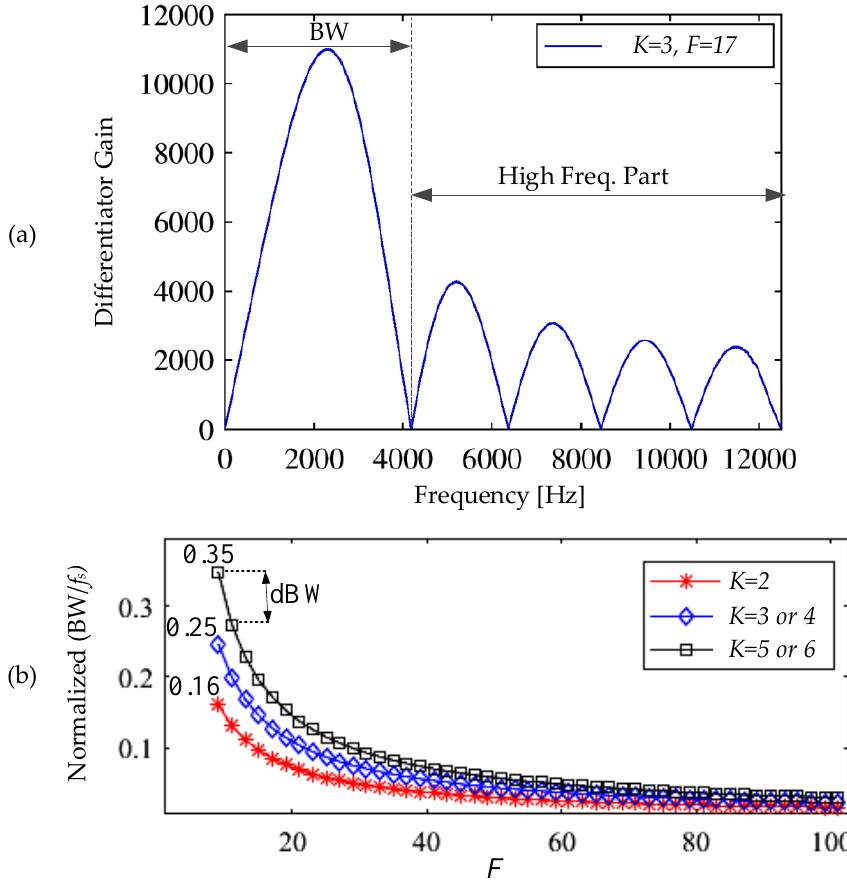
Figure 4. ( a ) Typical frequency response of an SGD sampled at 25 kHz, for F = 25 samples and a cubic polynomial, K = 3. ( b ) The influence of changing SGD parameters ( K , F ) on the BW and dBW.